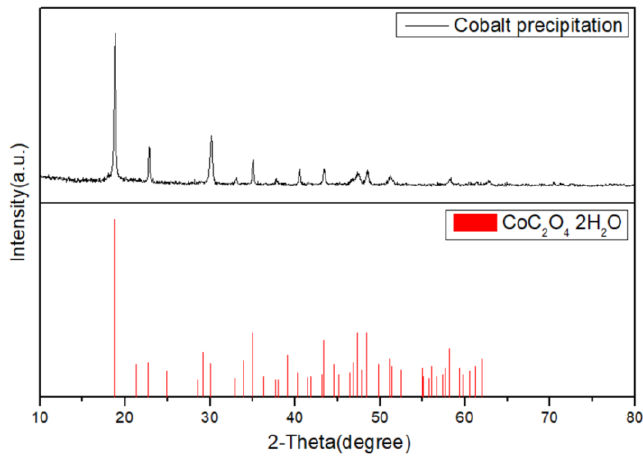
Figure 7. XRD analysis of CoC 2 O 4. Table 4. EDS analysis of CoC 2 O 4.